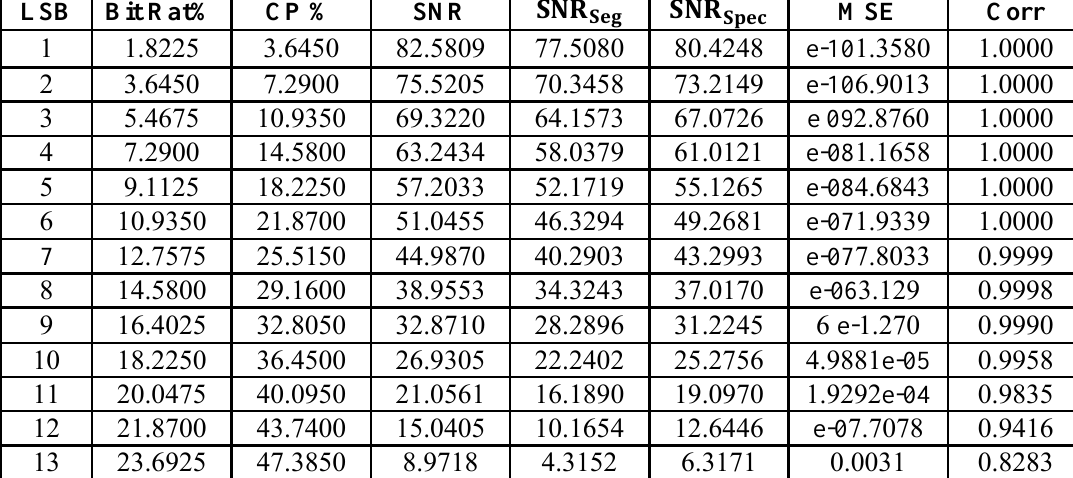
Table 2: Capacity calculation of the music audio (T=4 min, F=8000 Hz / Sec, ch=2,